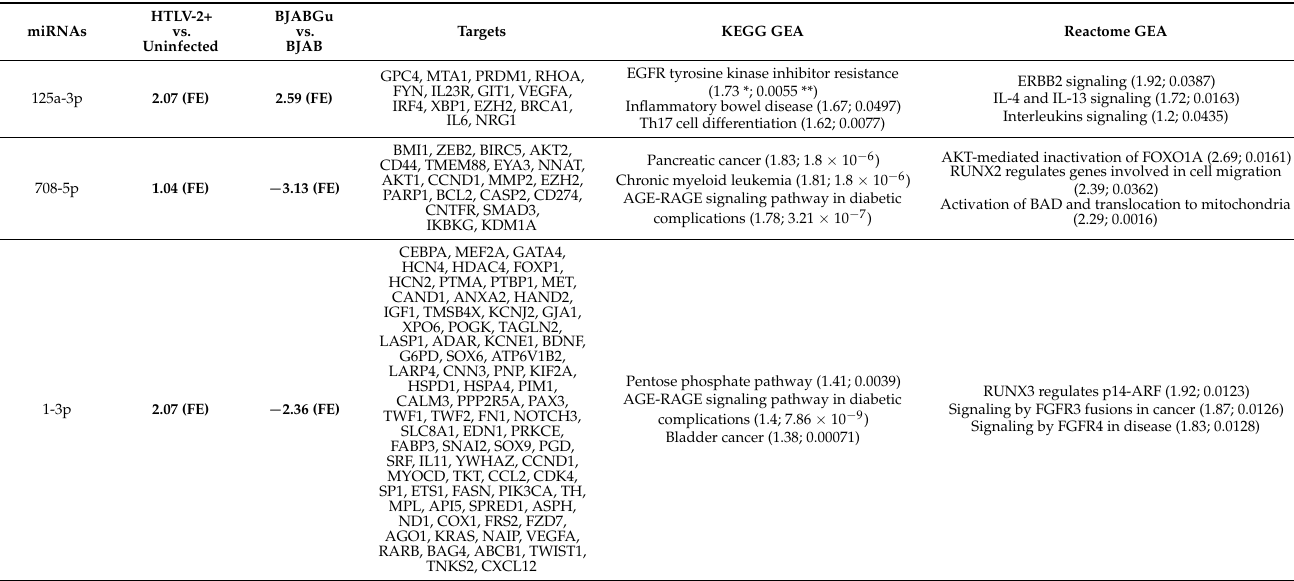
Table 2. Pathways enriched in the gene list of HTLV-2-related miRNA